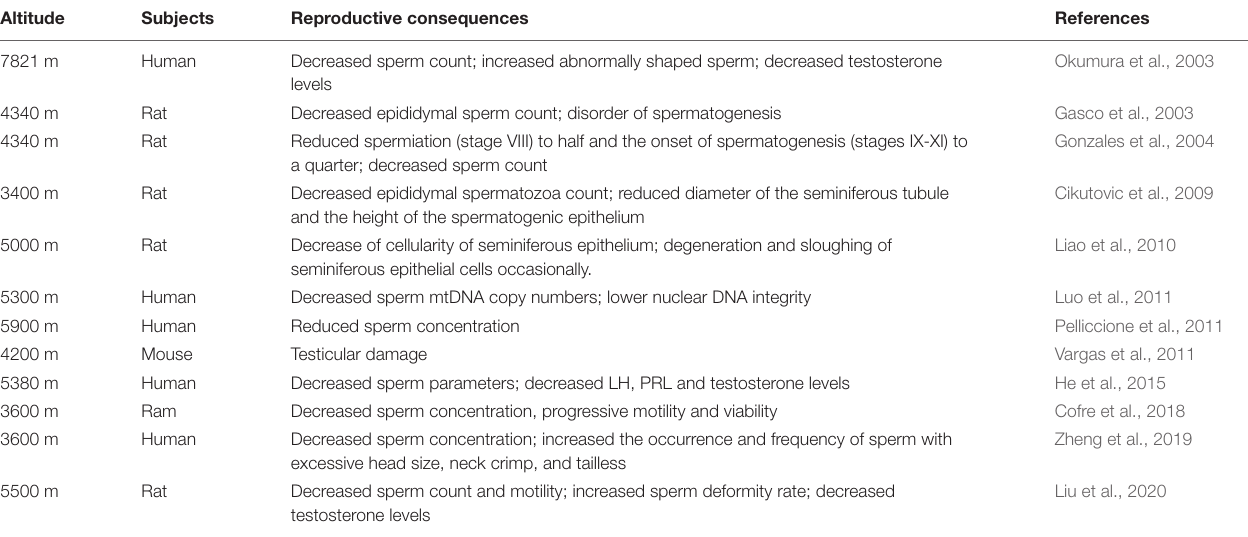
TABLE 2 | Summary of the studies reporting the reproductive consequence of varicocele. Subjects Reproductive